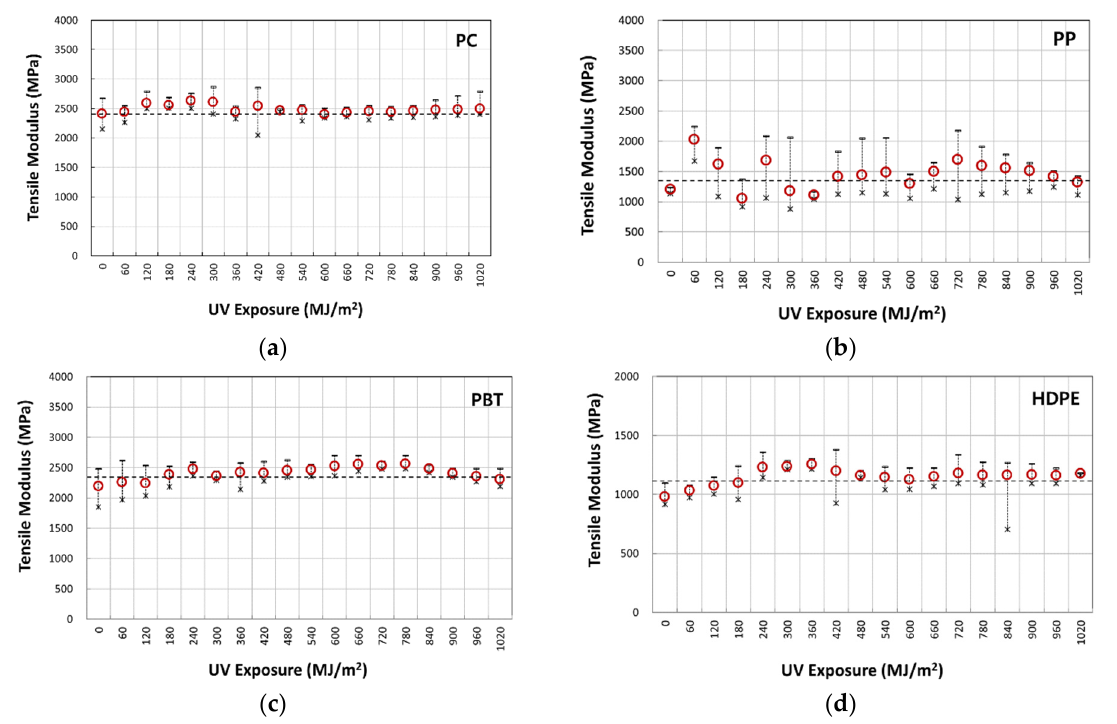
Figure 8. Variation of tensile modulus with UV irradiation dose: ( a ) PC; ( b ) PP; ( c ) PBT; and ( d ) HDPE.